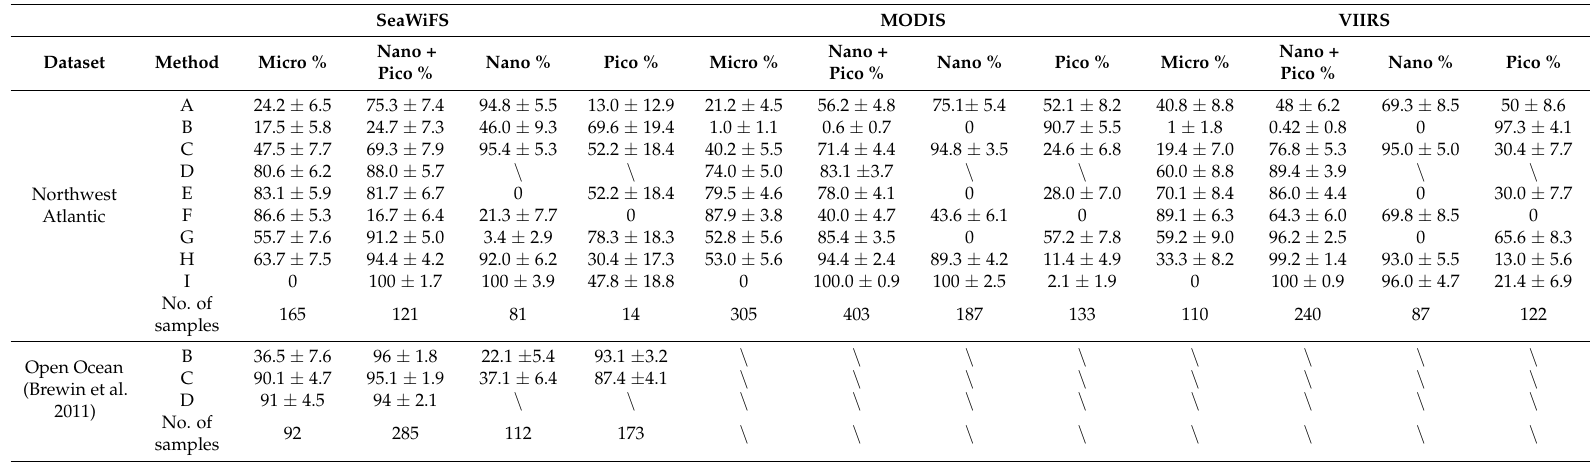
Table 3. Comparison results showing the percentage accuracy of different models with SeaWiFS, MODIS, and VIIRS products as model inputs. The comparison results of models B, C, and D in the Open Ocean conducted by Brewin, et al. [30] are also